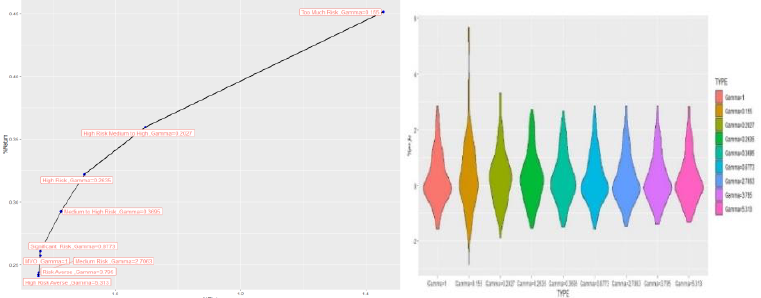
Figure 6. Return and Violet Risk for Experimental Data for Different Gamma Values (Research